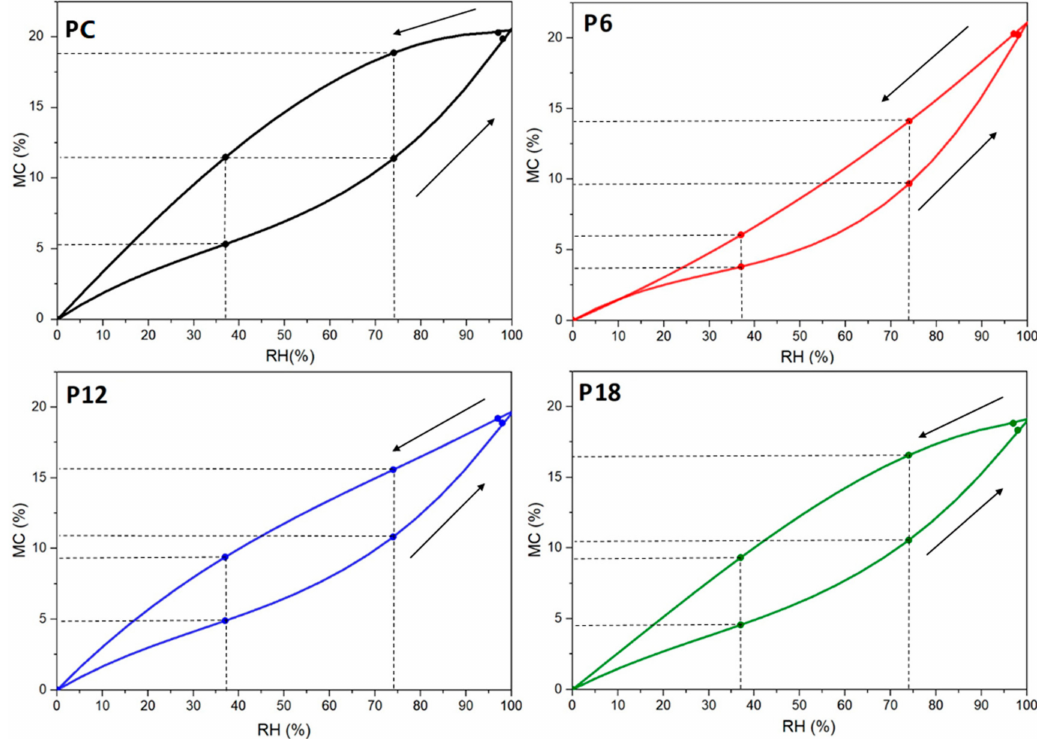
Figure 3. Experimental sorption–desorption isotherms of untreated and esterified pinewood. (RH = Relative